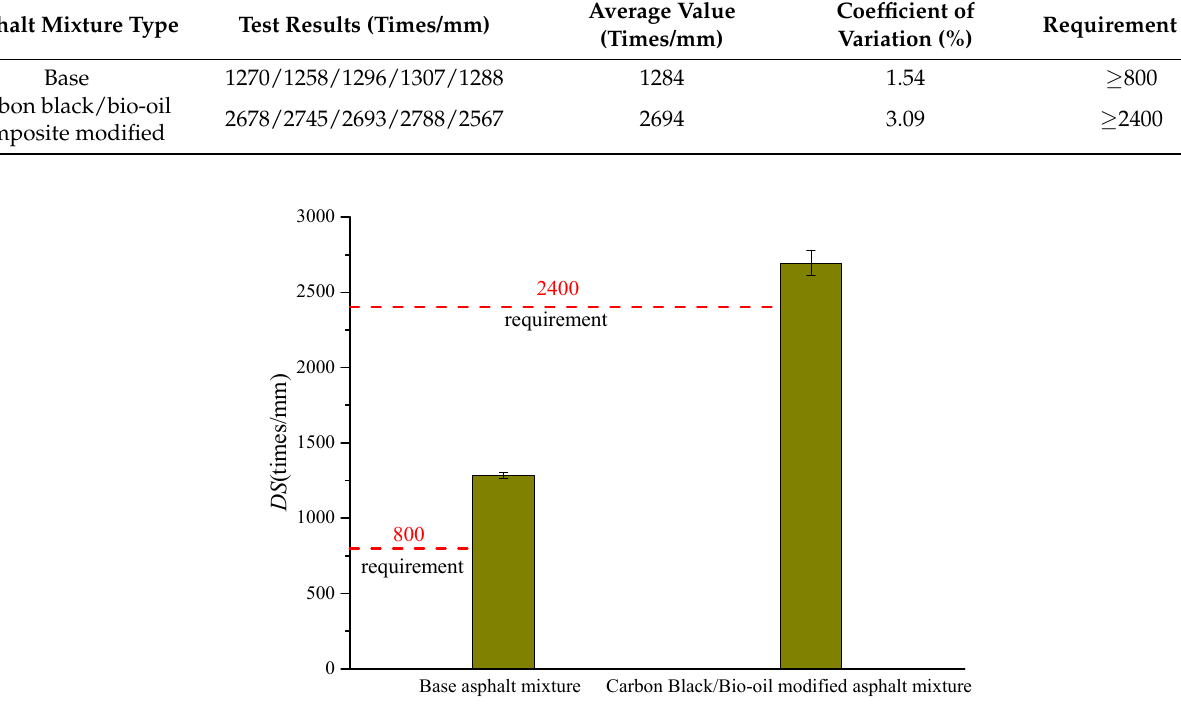
Figure 7. Comparison of DS results of different asphalt mixtures.